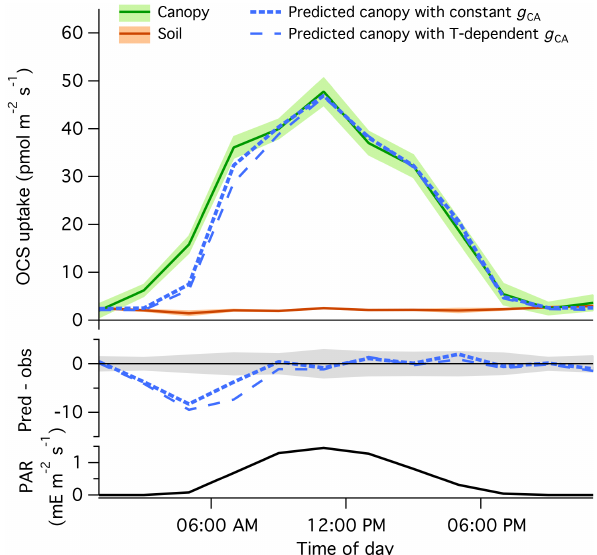
Figure 2. Composite diel cycles (including May through October of 2012 and 2013) of soil uptake, canopy uptake, and predicted canopy uptake from Eq. (1), along with the differences between predicted and observed canopy uptake and PAR for reference. Lines connect the mean values of each 2h bin. Pale bands depict standard errors in the means as estimated from the variability within each